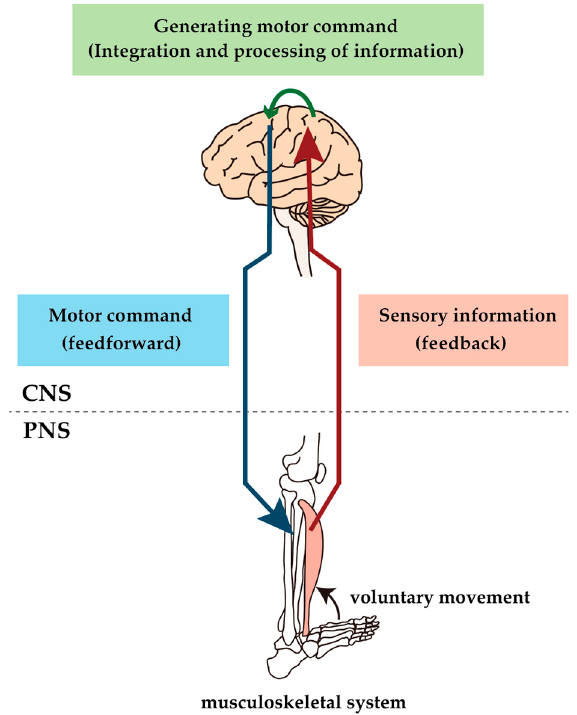
Figure 1. Conceptual diagram of sensorimotor control. Voluntary movements are produced by sending motor commands created by the brain through the spinal cord via motor descending pathways to the muscles, which result in muscle contraction. The result of the movement is feedback to the brain via the peripheral sensory nerve and ascending pathway, and the brain uses this information to make appropriate modifications to the motor commands. The constant activity of this loop causes voluntary movement to be performed; lesions at any level of the loop would impair voluntary movement.